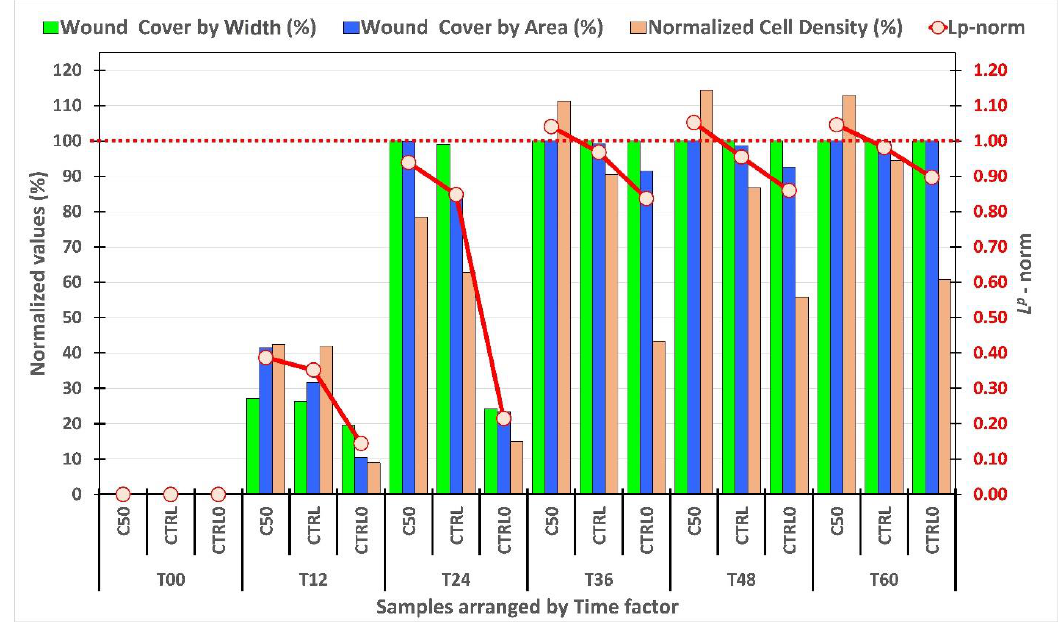
Figure 4. Evolution of the migration of fibroblasts and “gap coverage” with respect to statistical factor “Time” (average values). The quantitative parameters were: wound closure by width, wound closure by area and normalized cell density inside the wound.